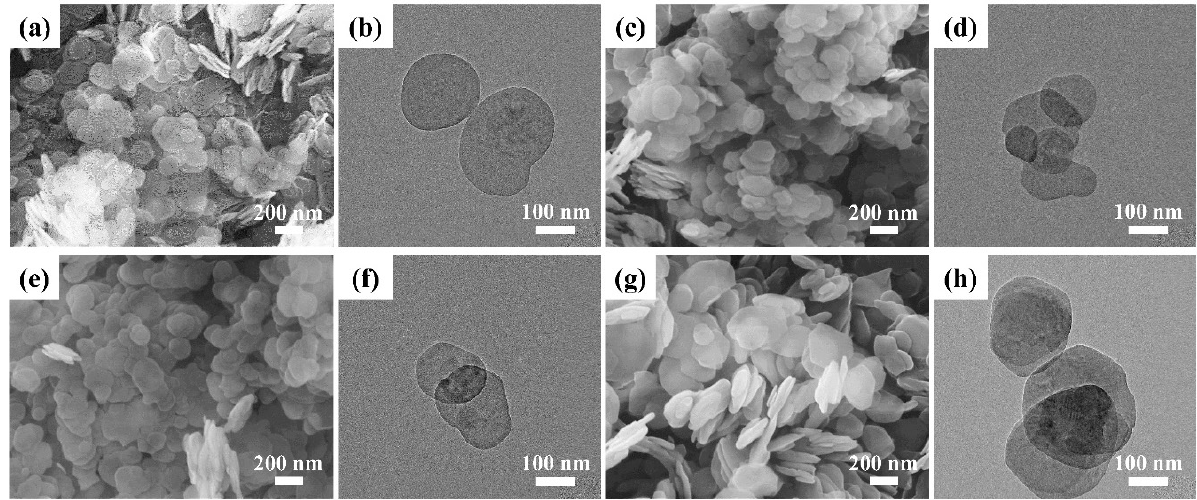
Figure 3. Scanning and transmission electron microscope image of ( a , b ) pristine MgAl-LDH, ( c , d ) Ga@LDH-0.5, ( e , f ) Ga@LDH-2, and ( g , h ) Ga@LDH-24. Table 2. Hydrodynamic radii, zeta potential, and particle dimension of parent LDH and Ga@LDHs. Colloidal Sample